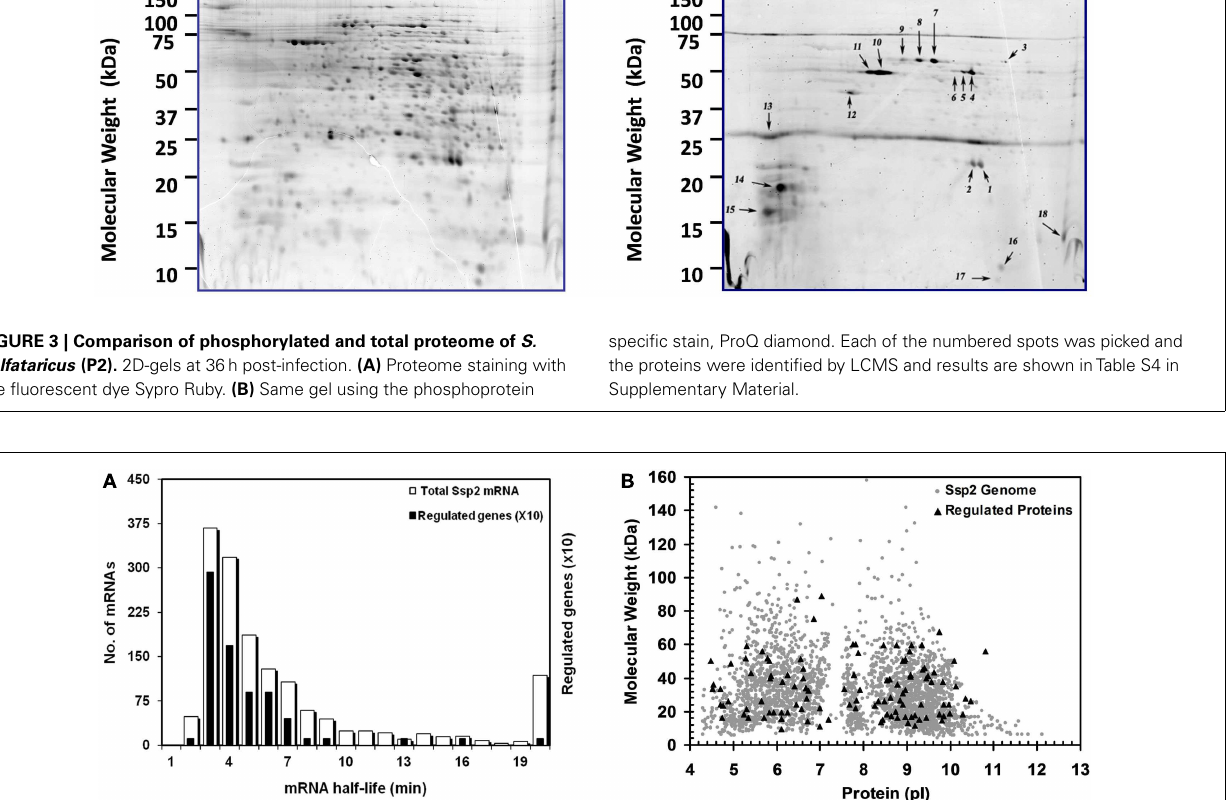
shown 10X for clarity; (B) Virtual 2D gel of S. solfataricus (P2) proteome. Calculated MW and pi distribution for the regulated proteins (triangles) and all predicted S. solfataricus (P2) genes (grey circles).The regulated proteins were found to be biased with respect to pi ( p =0.001) but not MW ( p =0.41) based on a Kolmogorov–Smirnov